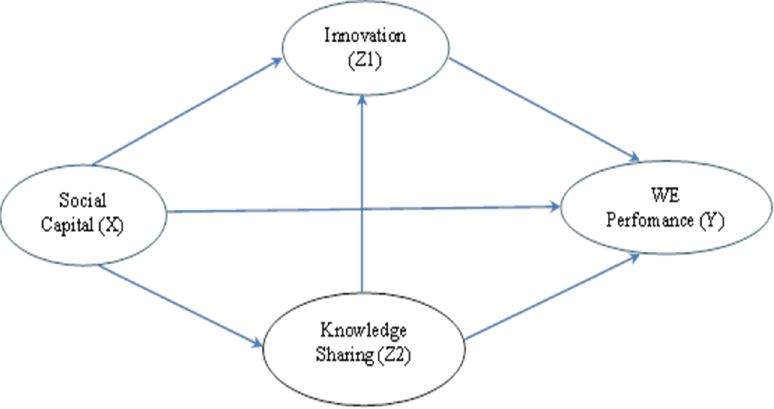
Figure 1. Research concept framework. Source: authors’s own elaboration, Adoption of the model: [20,21,54].